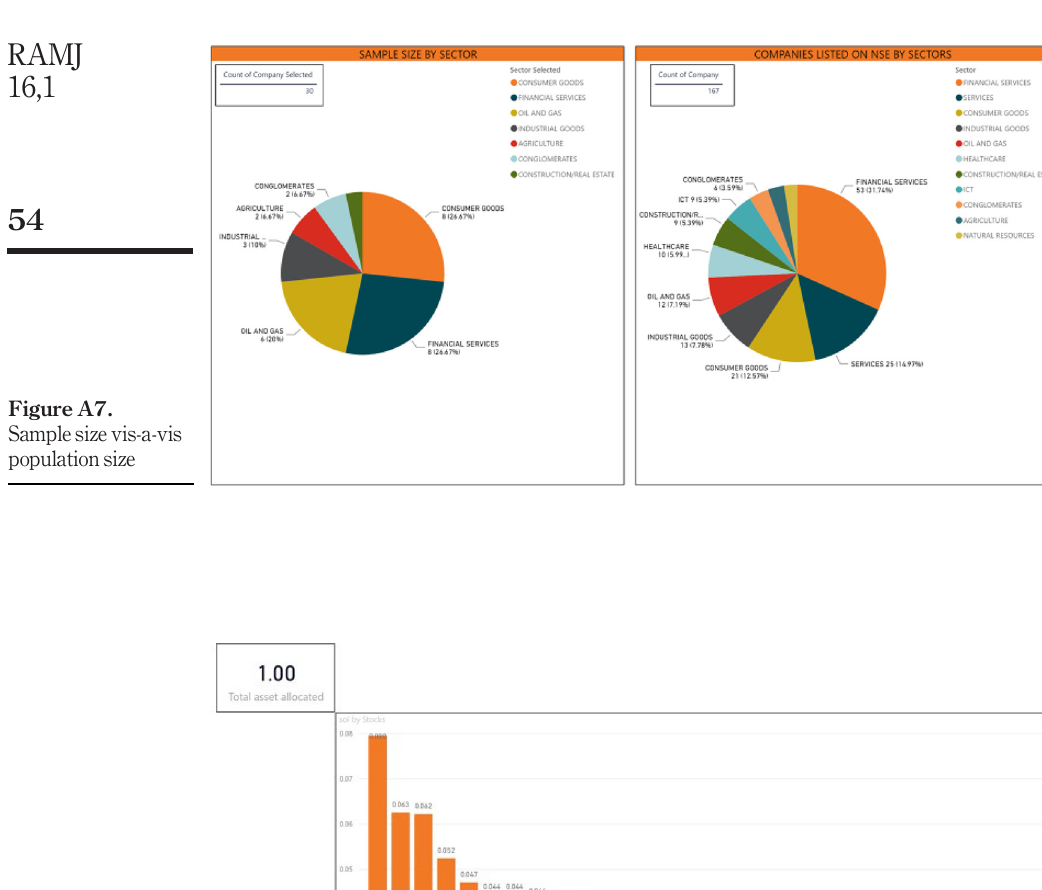
Figure A8. Optimal asset allocation for a portfolio containing all stocks in the sample